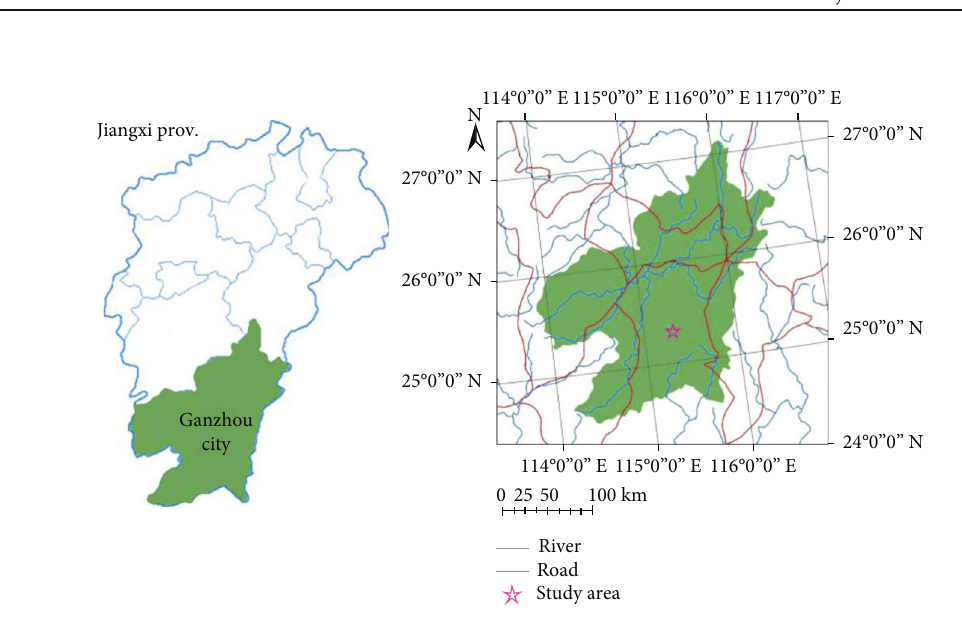
Figure 3: Location map of the study area.